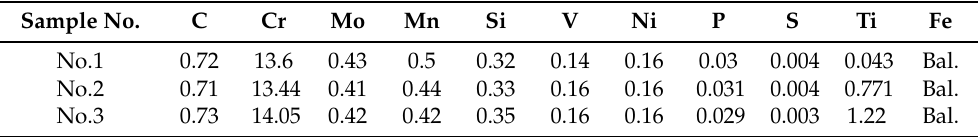
Figure 1. The flow chart of spheroidizing annealing. Table 1. Chemical composition of 8Cr13MoV steel (mass